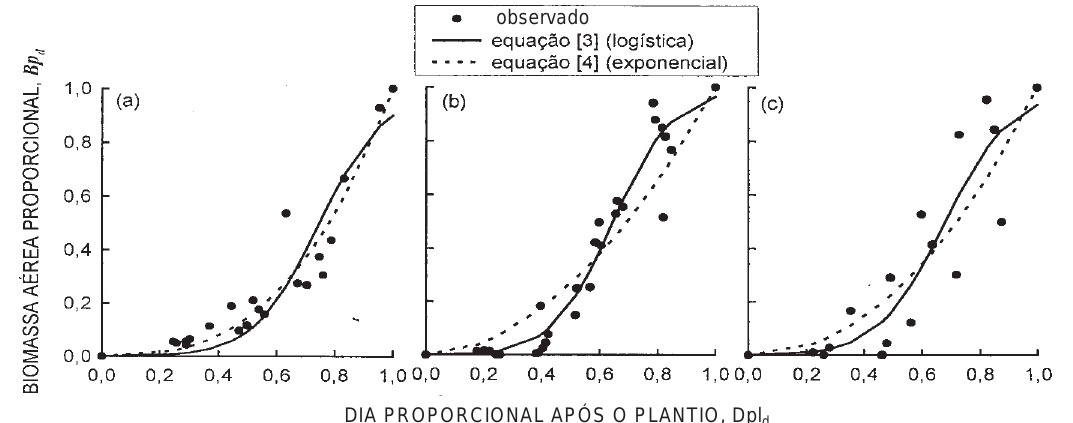
Figura 1. Relação entre biomassa aérea proporcional e dias após plantio proporcional, para as culturas do feijão (a), milho (b) e soja (c), e curvas geradas pelas equações [3]